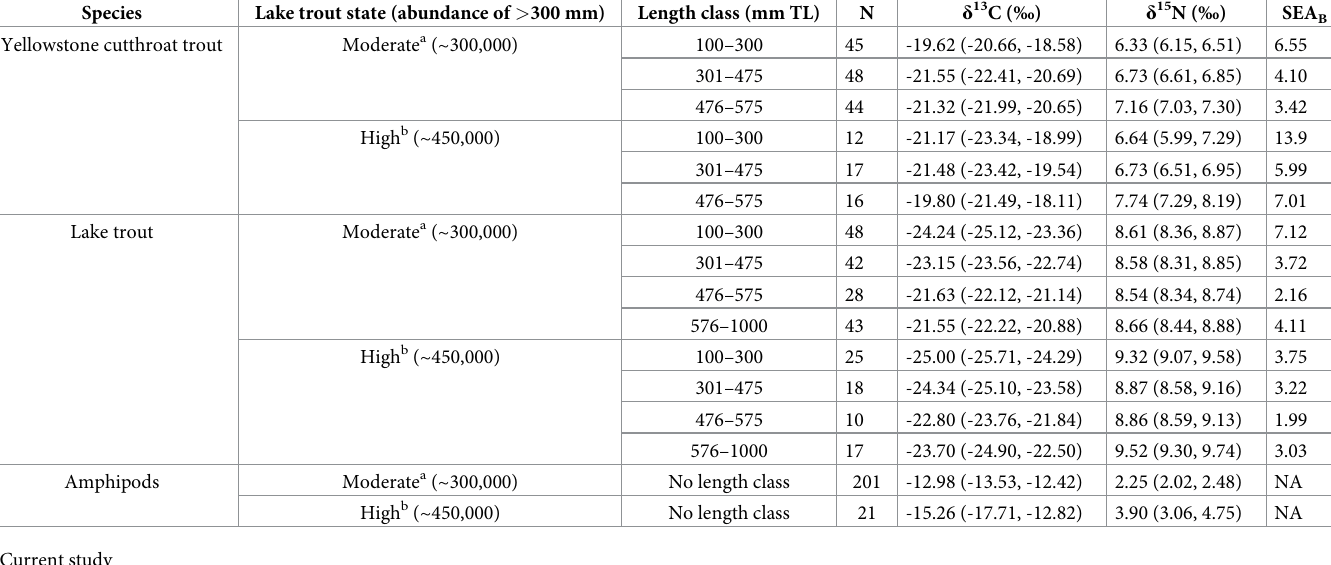
Table 1. Comparison of stable isotope signatures for native and invasive trout between lake trout density states. Sample sizes (N) and mean δ 13C and δ 15N (95% confidence intervals in parentheses) and median posterior distribution value of standard Bayesian ellipse areas (SEA B ) by lake trout density state (lake trout state) and length class for lake trout and Yellowstone cutthroat trout. Amphipods included to demonstrate basal isotope values. Lake trout state densities are from Syslo et al. [55].